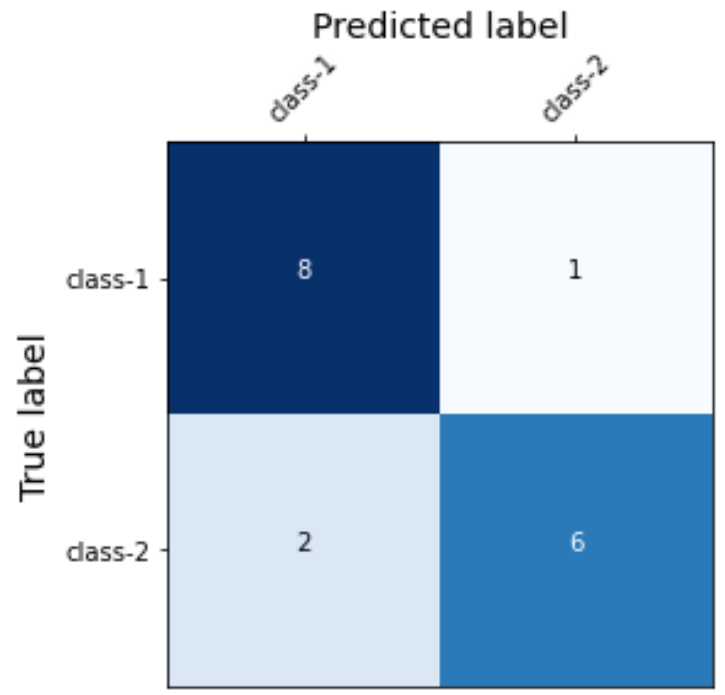
Figure 3. Confusion matrix of TF-IDF+LR and uni–bi–tri-gram + LR.